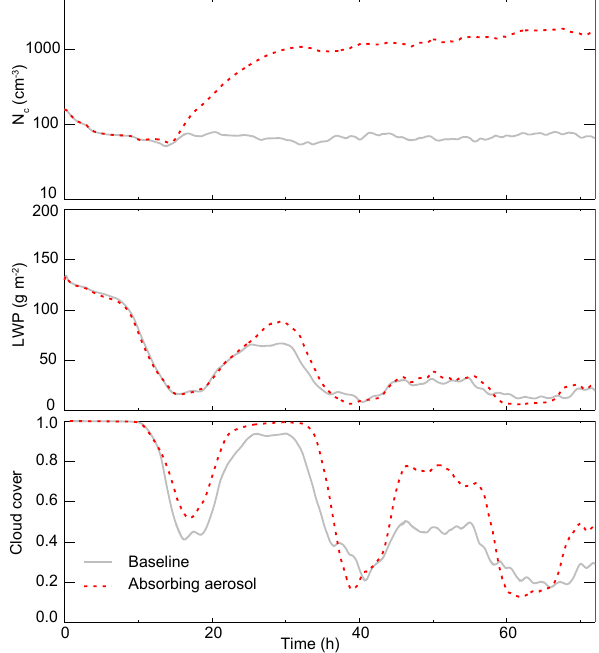
Figure A2. As in Fig. 2 but for a lightly drizzling baseline and with absorbing aerosol in the absence of sedimentation and evaporation